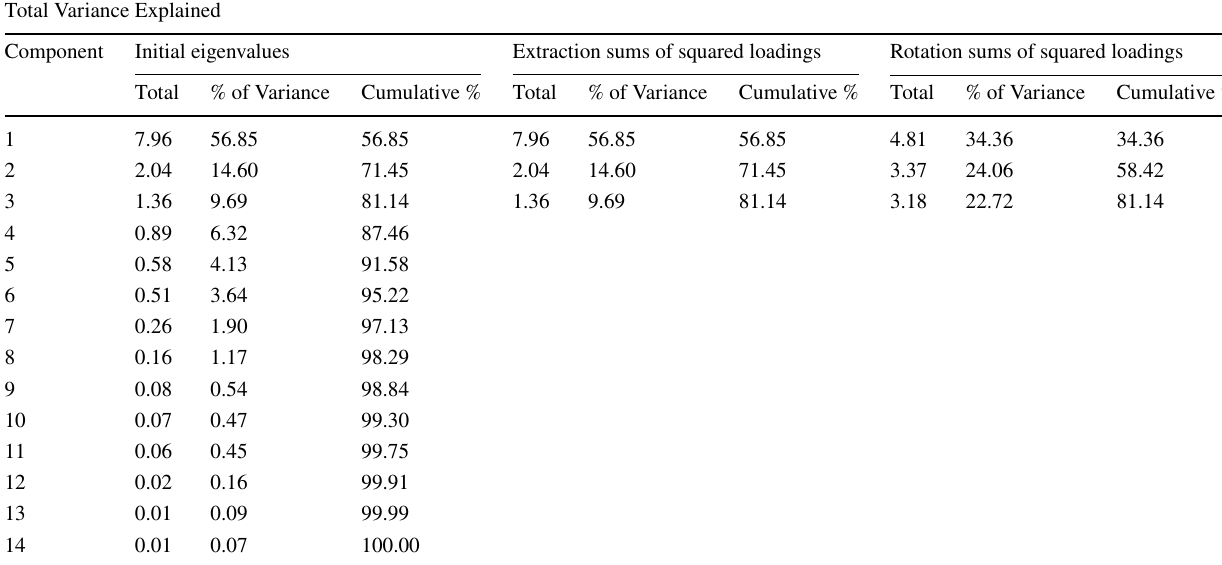
Table 3 The total variance of the hydrochemical components Total Variance Explained Component